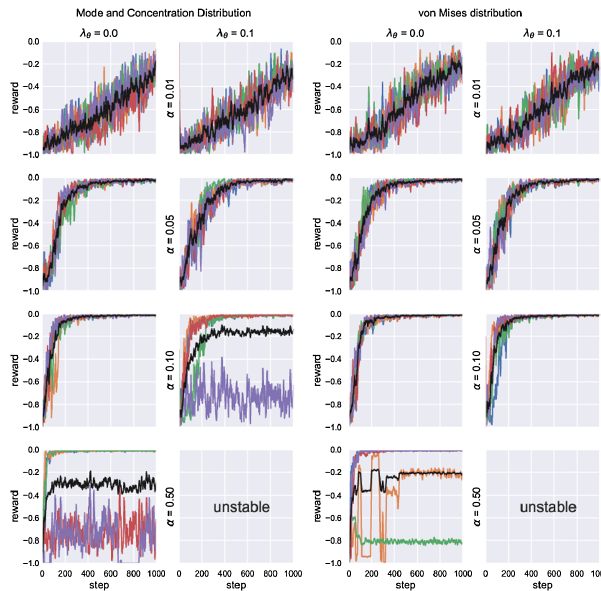
FIG. 5. This task has almost the same parameters as those given in Fig. 4, the only change is that the target is now 0.5 instead of − 0 . 5 . In addition to those parameters, the value of the target at each step is changed to include uniformly sampled noise that is updated at every